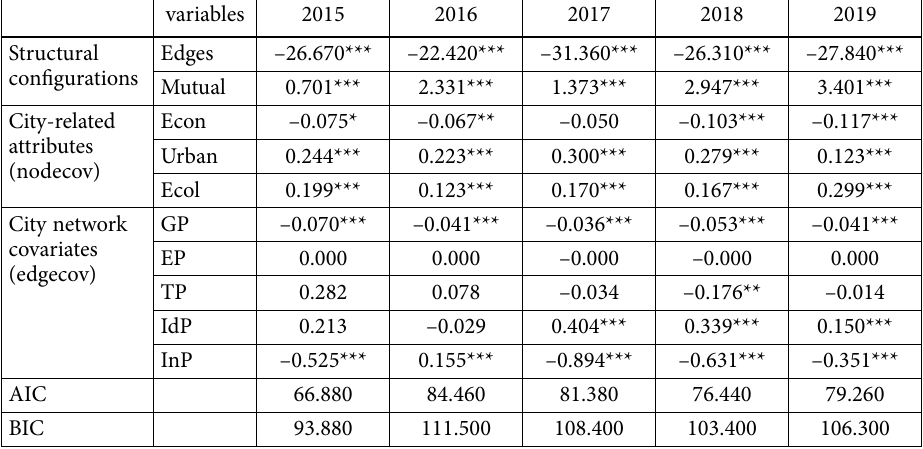
Table 7. Parameter estimation results of the ERGM